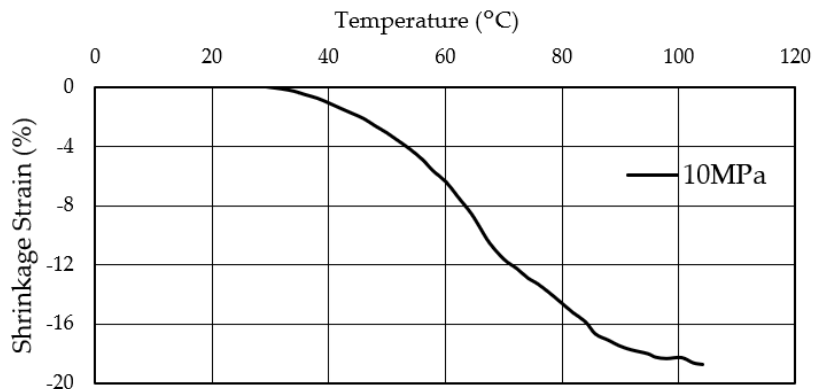
Figure 5. Surface temperatur − shrinkage strain relationship of TCPA.